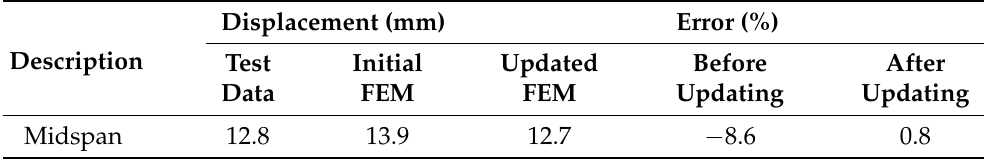
Table 5. Results of the static analysis before and after updating.